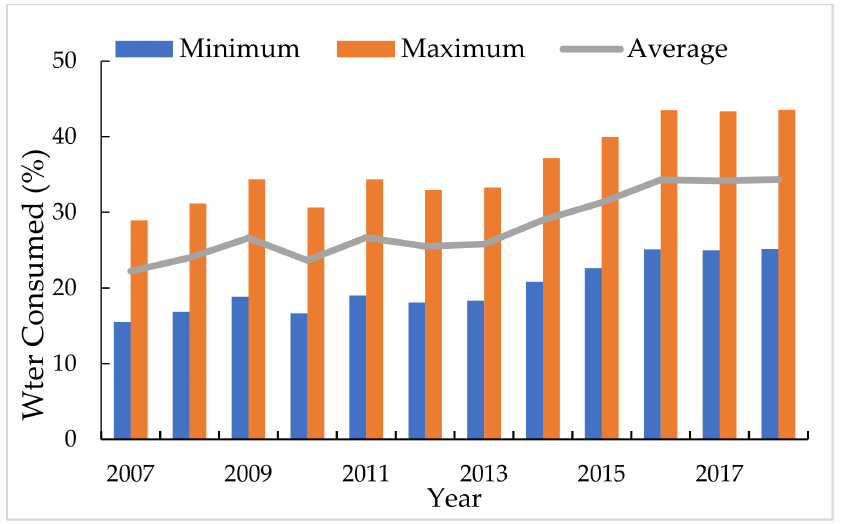
Figure 11. Water consumed for Qat plantation of the total water used in agriculture (in